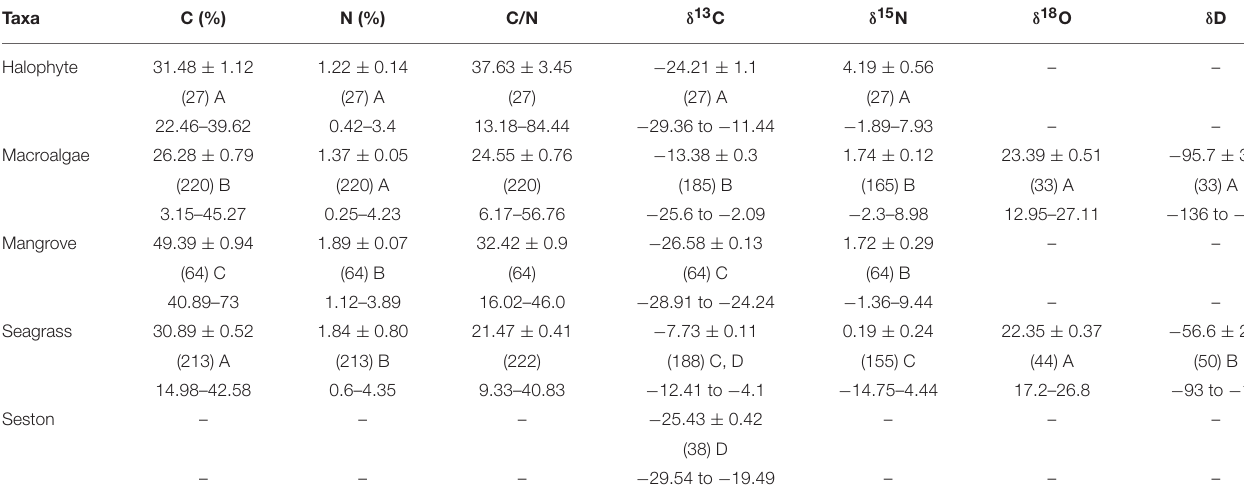
TABLE 2 | Mean ± SE of the concentration of carbon (C) and nitrogen (N) and the C/N and the stable isotopes of carbon ( δ 13 C), nitrogen ( δ 15 N), oxygen ( δ 18 O), and hydrogen ( δ D) measured in the blades of the different taxa of primary producers.